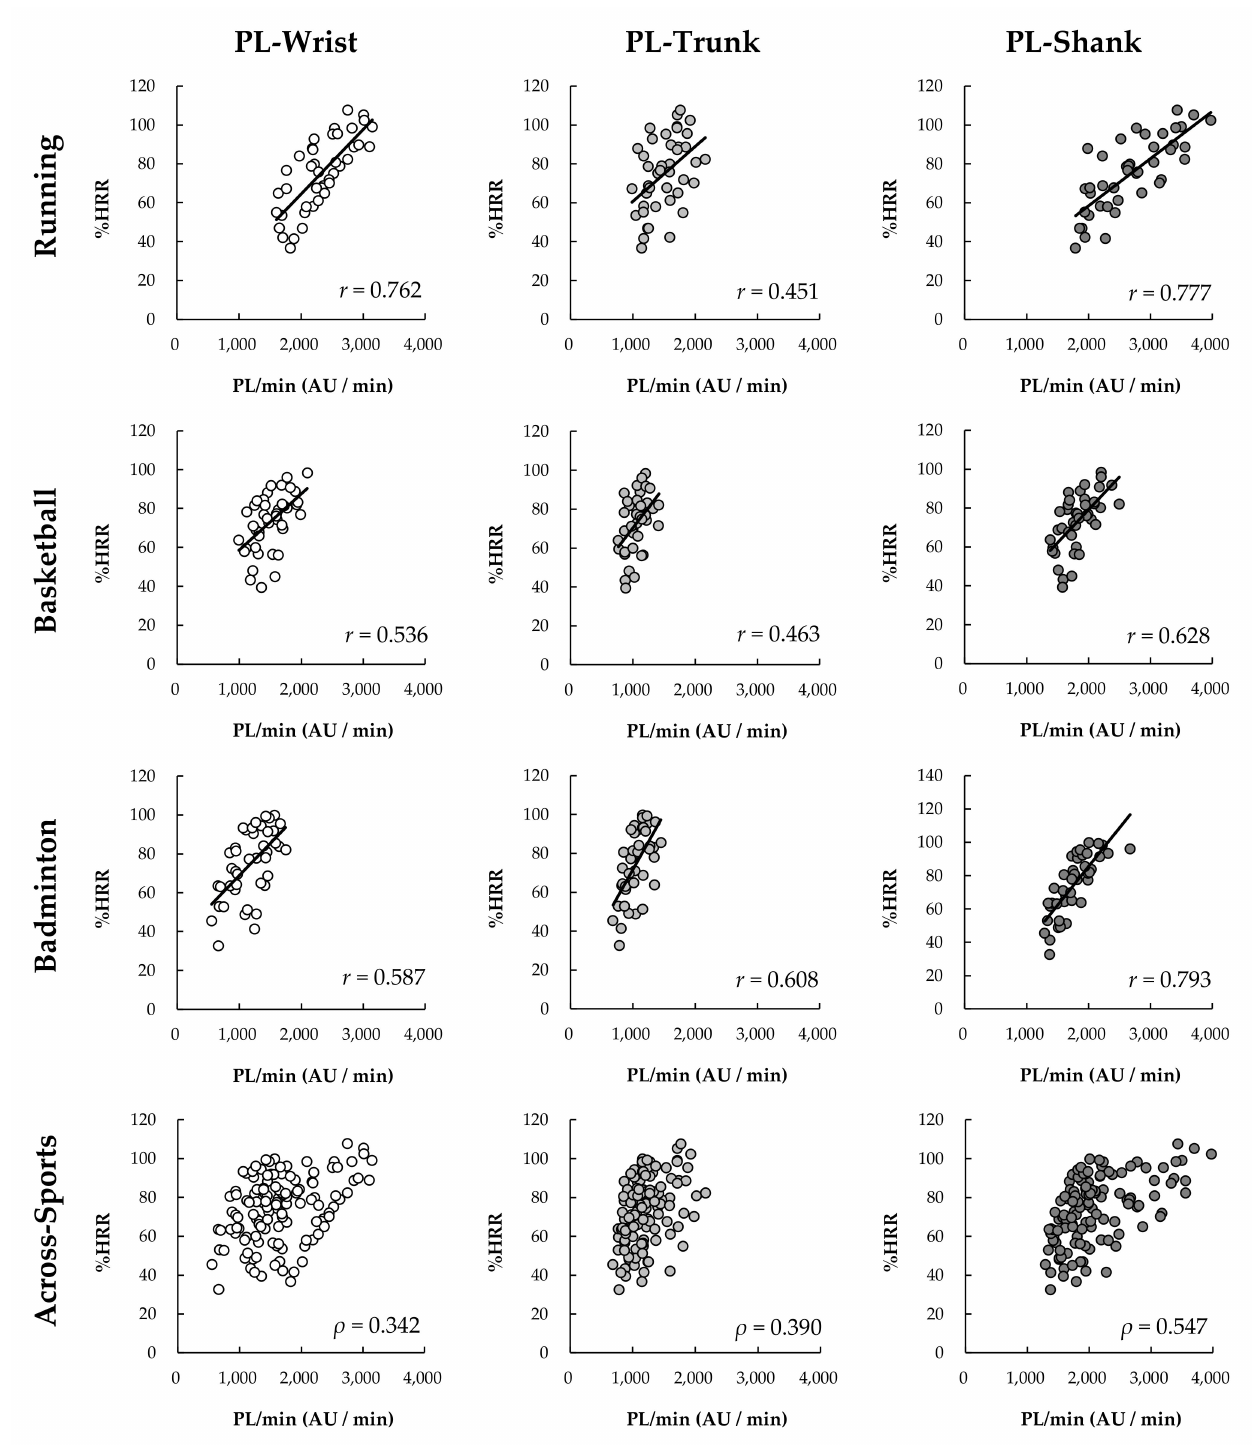
Figure 6. The within-sport Pearson ( r ) ( n = 42) and across-sports Spearman ( ρ ) ( n = 126) correlation coefficient for %HRR and